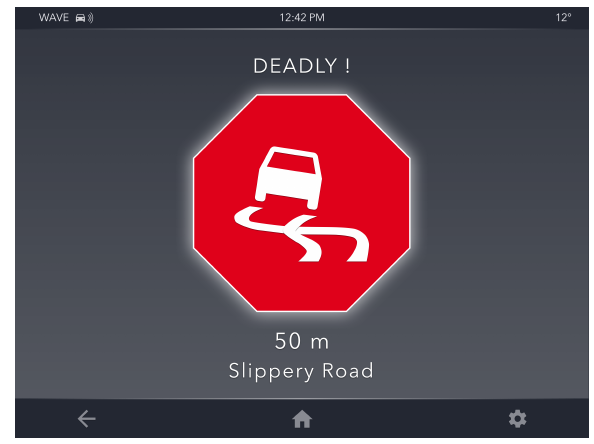
Figure 1. One-stage warning GUI.